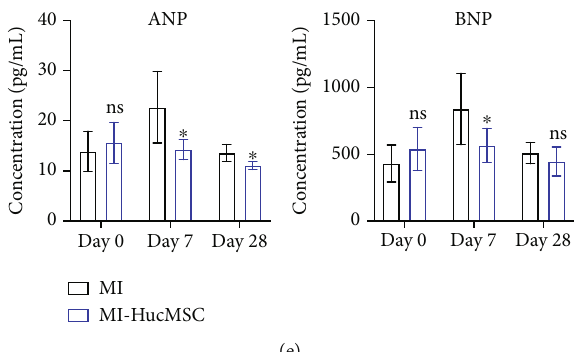
Figure 1: Distribution and e ff ects of iv-administered HucMSC after infarction. (a) Schematic diagram of the study design. (b) Biodistribution of DiR-labeled HucMSC in di ff erent organs was measured at baseline, 7-day and 28-day post-MI. n = 3 mice for each group. (c) Biodistribution of DiR-labeled HucMSC in the heart at 0-, 1-, 3-, 5-, and 7-day post-MI. n = 3 mice for each group. (d) Representative echocardiography (upper panel) and calculation of LVEF and LVFS at baseline, 7-day and 28-day post-MI (lower panel). n = 8~ 9 mice for each group. (e) Serum ANP and BNP levels were measured at baseline, 7-day and 28-day post-MI by ELISA assay. n = 5~ 8 mice for each group. ns, non-signi fi cant vs. MI group; ∗ p < 0 : 05 vs. MI